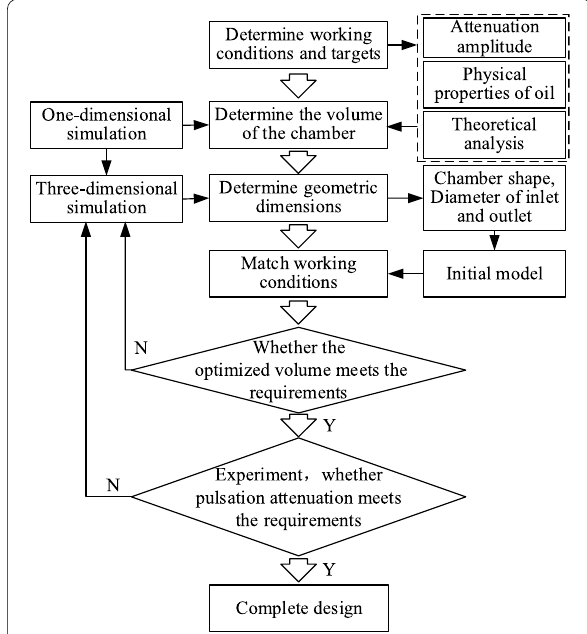
Figure 34 Design flow of pressure pulsation